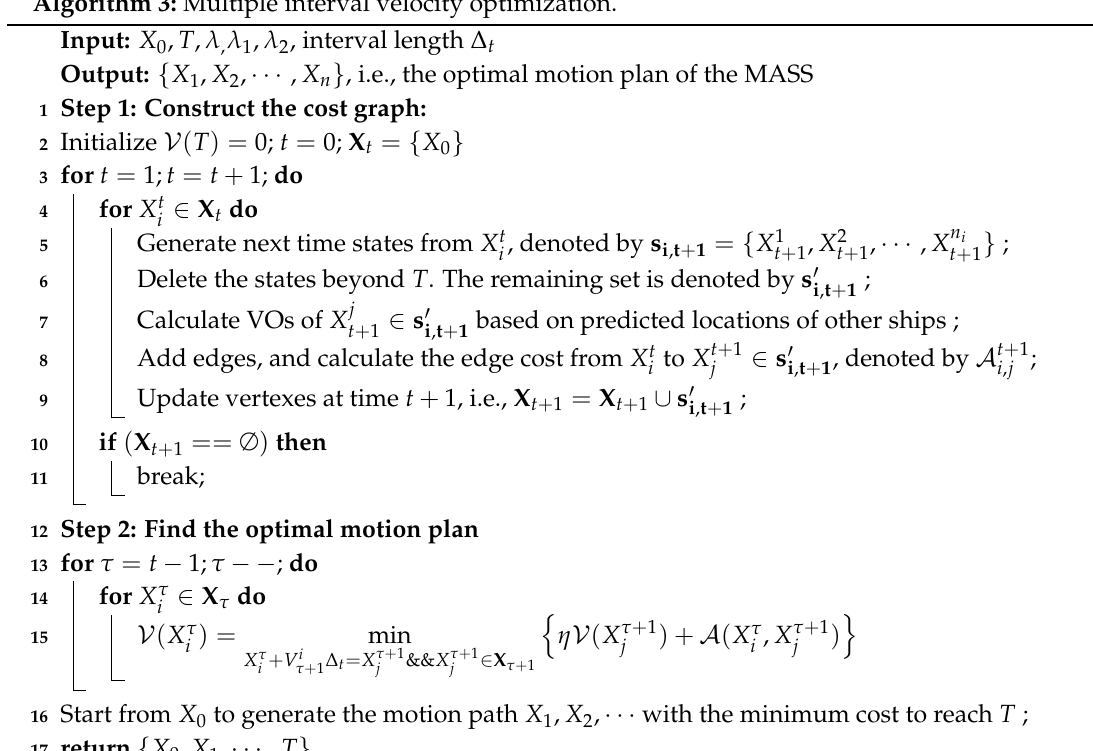
Algorithm 3: Multiple interval velocity